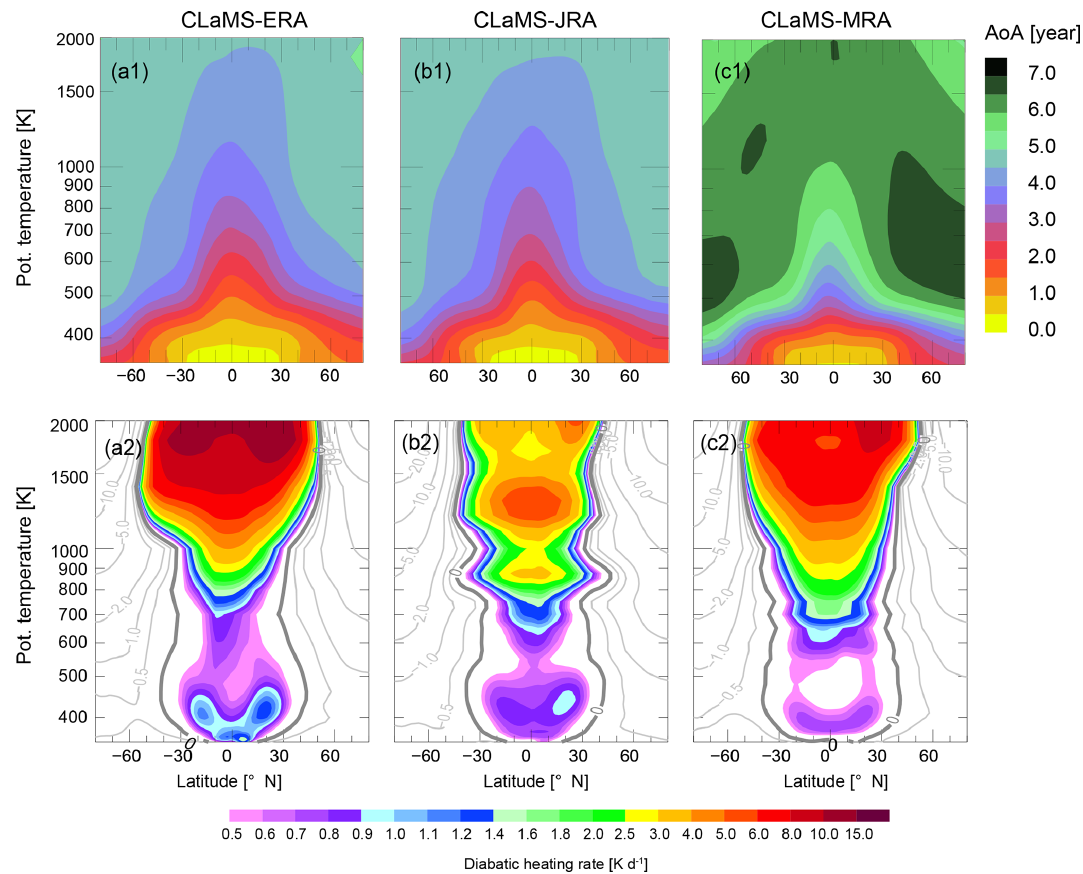
Figure 3. Comparison of climatological annual-mean zonal-mean age-of-air (AoA) from the CLaMS-ERA, CLaMS-JRA and CLaMS-MRA simulations (a1–c1) , along with corresponding cross-isentropic velocities ( ˙ θ ) based on total diabatic heating rates for each reanalysis product (a2–c2) . Color shading in the lower panels indicates zonal-mean diabatic upwelling rates that exceed 0.5Kd − 1 . The thick gray line shows the zero-contour of diabatic heating rates. Lighter thin gray lines show diabatic downwelling.